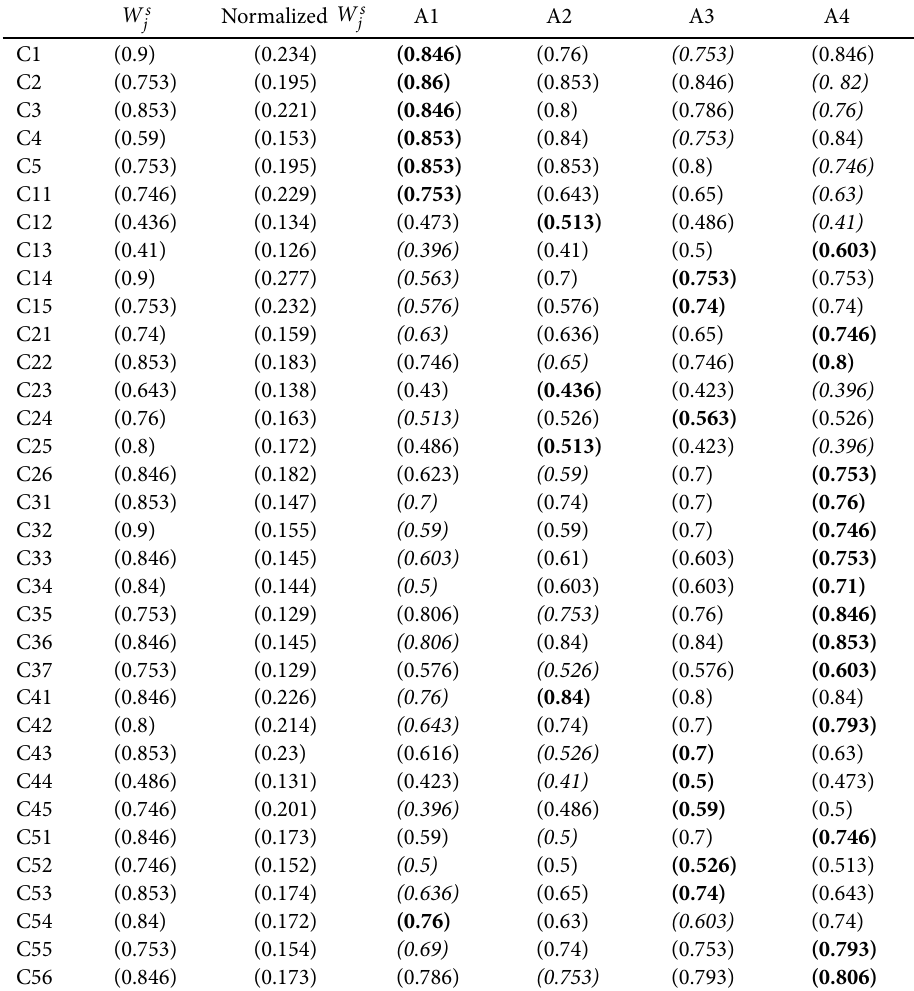
Table 4. Defuzzyfied aggregated fuzzy values of the cities’ rates